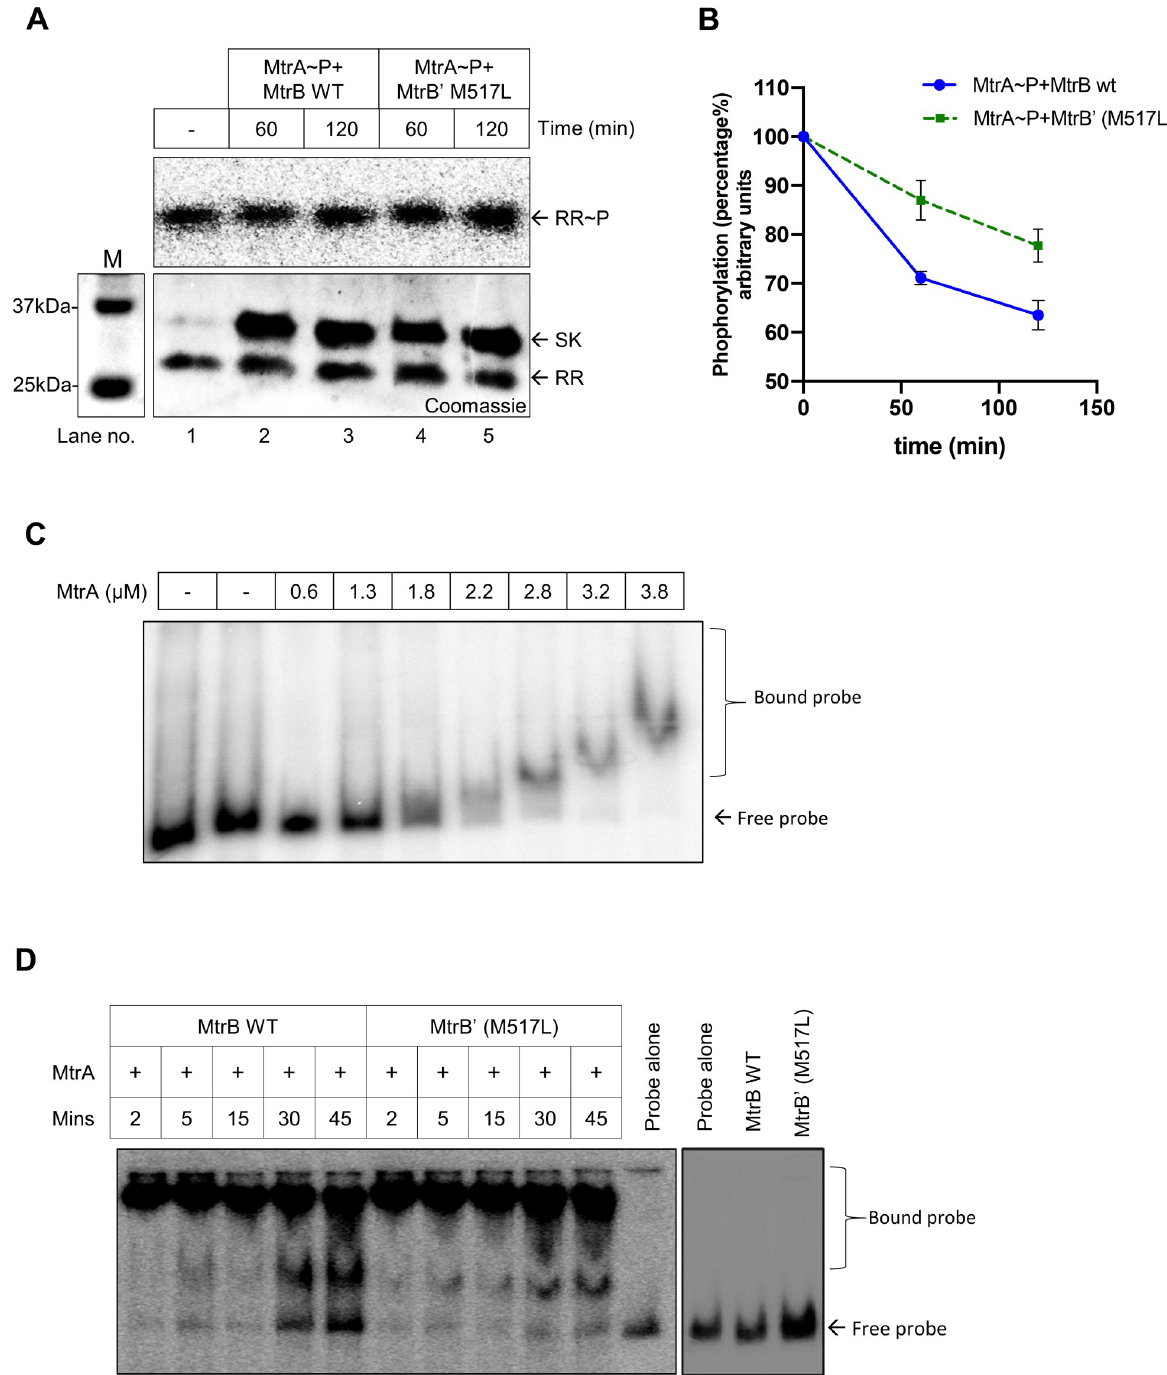
Fig 3. Effect of the mutation on the phosphatase activity of the SK on RR~P and its DNA binding ability. A. Dephosphorylation analysis of MtrA~P through wild type or mutant MrB. MtrA~P was generated as described in the Methods section and incubated with the wild type or mutant MtrB for the indicated time points. M, marker. B. Quantitative measurement of the amount of MtrA~P remaining at the indicated time points is shown in Fig 3A. The signal recorded with MtrA~P in the absence of SK was taken as 100, and the other time points were normalized to it to calculate the percentage of phosphorylated RR (n = 3). C. Titration of MtrA RR protein concentration to determine the minimal concentration of unphosphorylated MtrA which can bind to the oriC . Labeled DNA were incubated with increasing concentration of MtrA protein (as indicated) and tested for mobility shift of the probe by EMSA. The RR KdpE was used as a negative control to evaluate nonspecific binding (lane 2). D. A comparative analysis of MtrA binding to oriC DNA as a function of phosphorylation through wild-type or mutant MtrB’ SK proteins used at different concentrations. For all experiments, n = 3 biological replicates and a representative image is